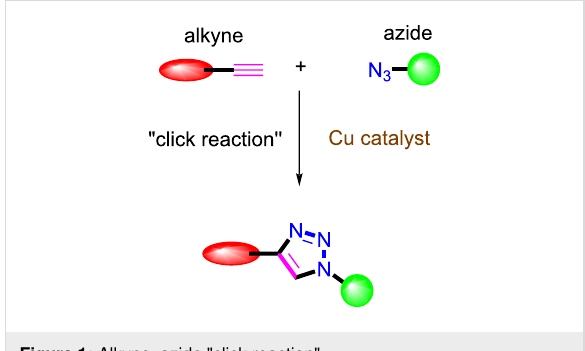
Figure 1: Alkyne–azide "click reaction".